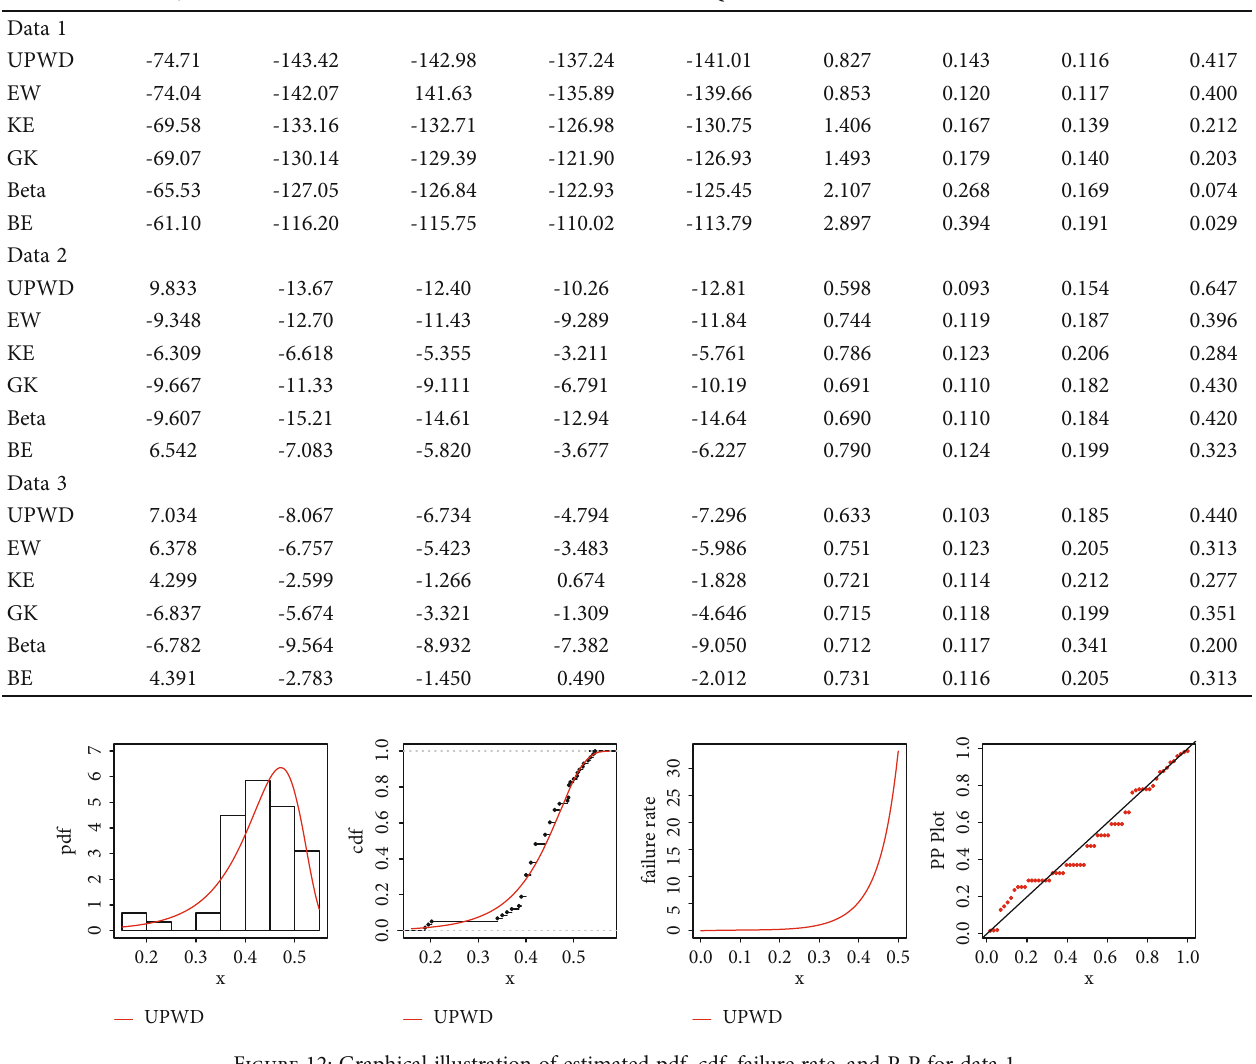
Table 5: Detailed summary of accuracy measures of the fi tted models. Dist.